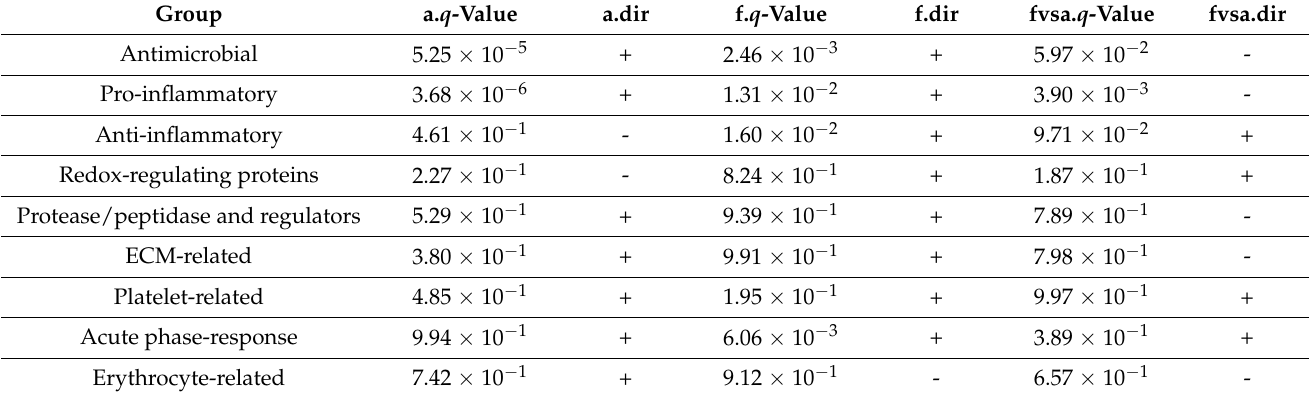
Table 1. Summary table for competitive group enrichment tests showing results for pairwise comparisons between the adult and fetal groups. The adult (a) injury response comparing adult injured versus adult control samples, the fetal (f) injury response comparing fetal injured versus fetal control samples, and the difference between the injury responses (fvsa) comparing (f) versus (a) are detailed in the table. The direction of the change is indicated with a plus symbol for up-regulation and a minus symbol for down-regulation. We use the common FDR threshold of q < 0.05 for statistical significance. Supplementary Table S3 lists the proteins tested for each of the groups. Group a. q -Value a.dir f. q -Value f.dir fvsa. q -Value fvsa.dir Antimicrobial Pro-inflammatory